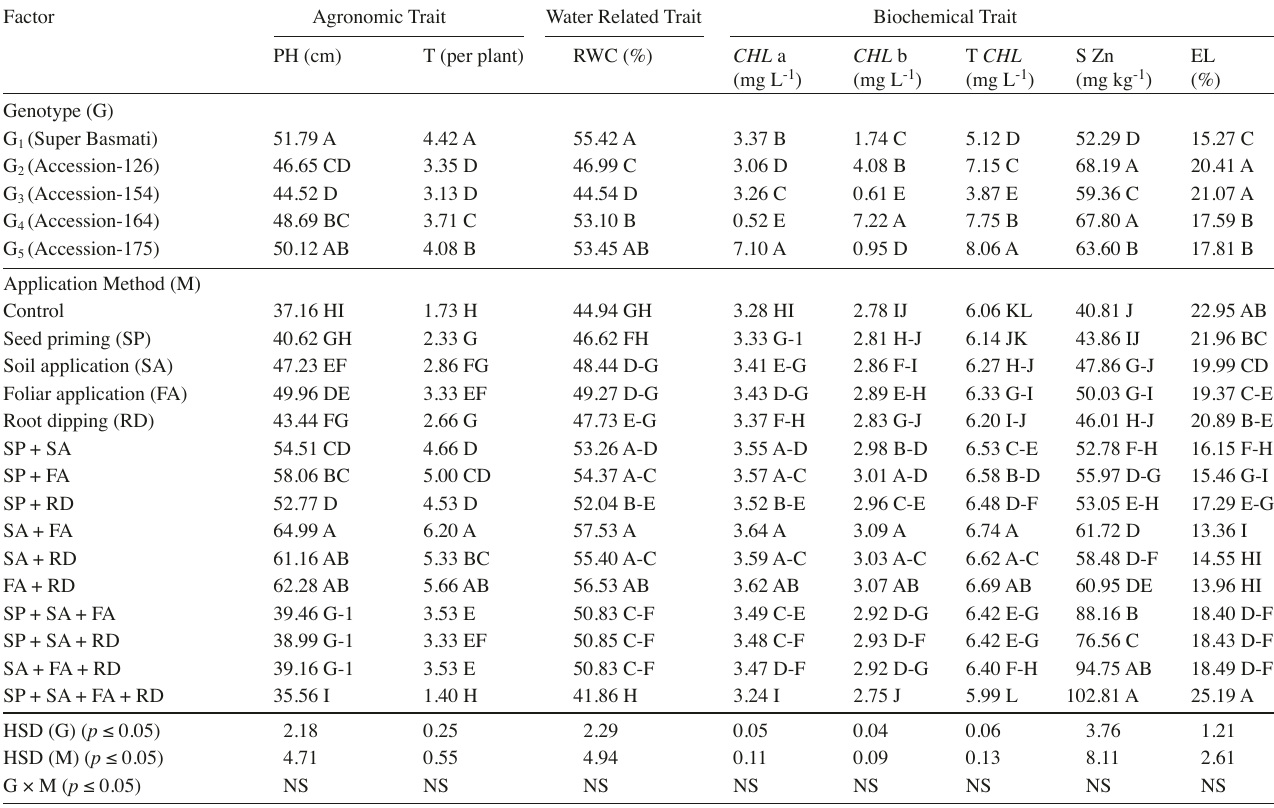
Agronomic Trait Water Related